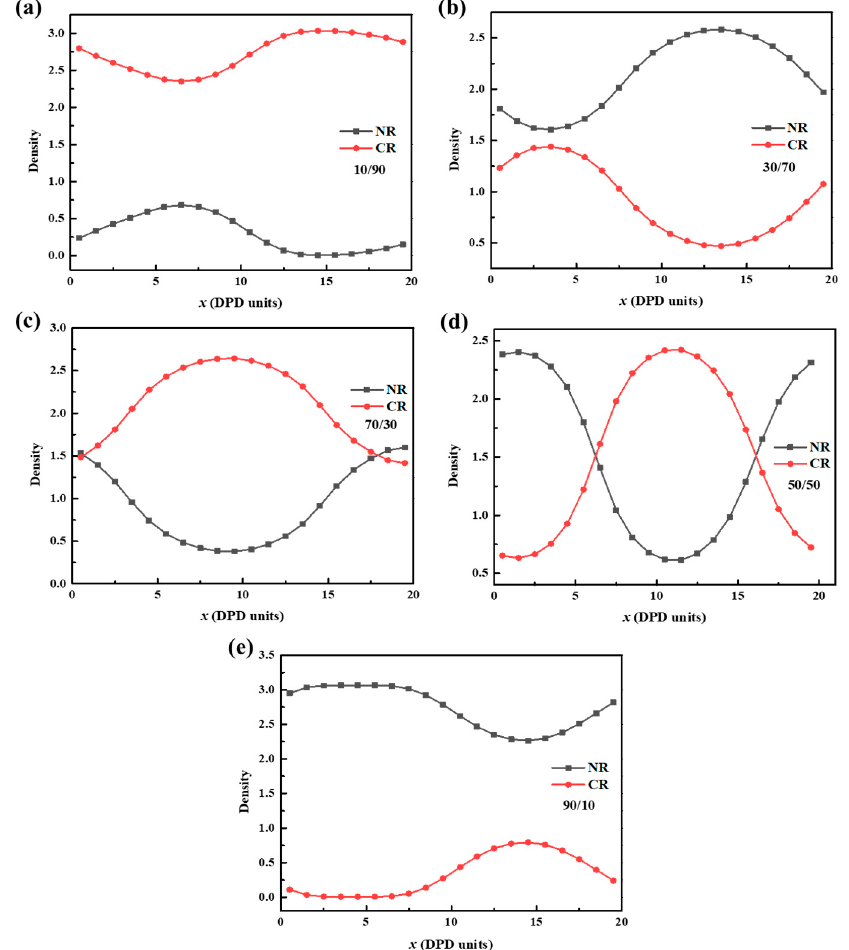
Figure 6. Variation of the density of different mass ratios ( a ) 10/90, ( b ) 30/70, ( c ) 50/50, ( d ) 70/30, and ( e ) 90/10 NR/CR blends along the x -axis of the simulation box.